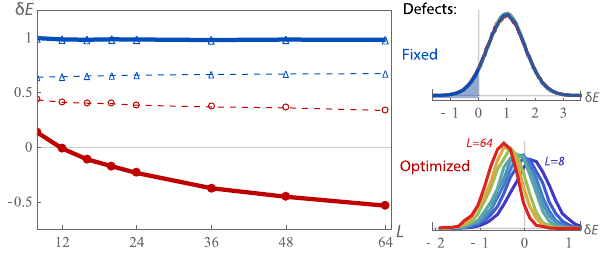
FIG. 4. Defect nucleation in the random dimer model. We obtained optimal dimer coverings numerically for an L × L triangular lattice, with random bond energies drawn from the interval ½ − 1 ; 1 (cid:3) . Monomer defects were introduced in two ways: (a) at fixed sites (blue triangles, top) and (b) at sites chosen, from L possibilities, to optimize the defect energy cost δ E (red circles, bottom). The histograms of the δ E distributions for various system sizes are shown on the right. Left: Their means (solid curves) and standard deviations (dashed). (a) Fixed defects typically cost energy δ E > 0 : the distribution of δ E converges to a fixed L ¼ ∞ shape, with a nonzero tail at δ E < 0 (shaded). (b) Optimized defects occupy these rare regions, giving an energy gain − δ E > 0 which appears to increase without bound as L → ∞